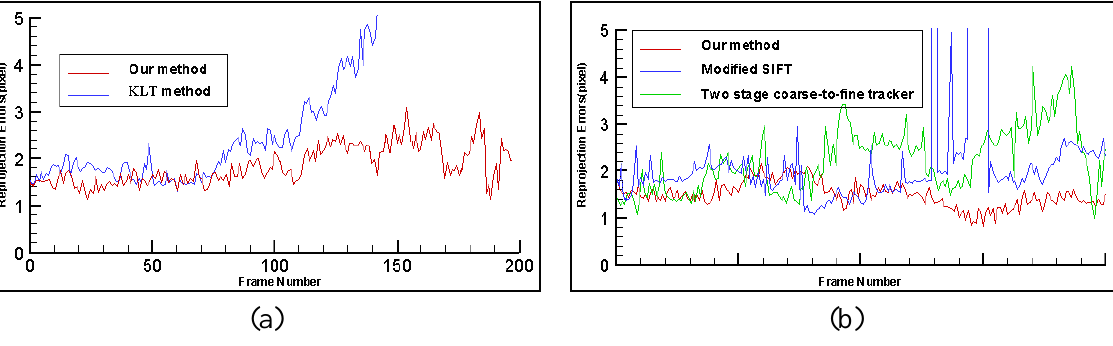
Figure 12. Errors comparison between our method and other